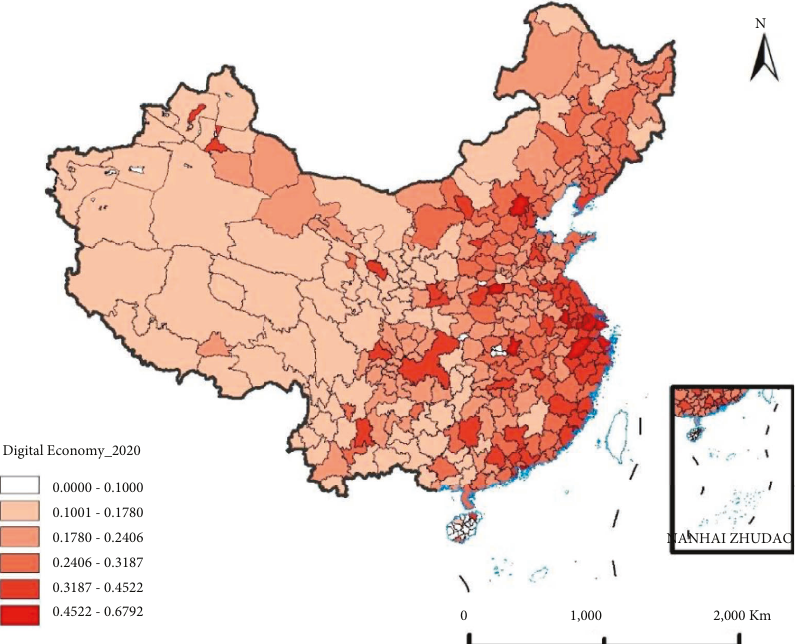
Figure 4: Spatial distribution map of China’s digital economy in 2020.